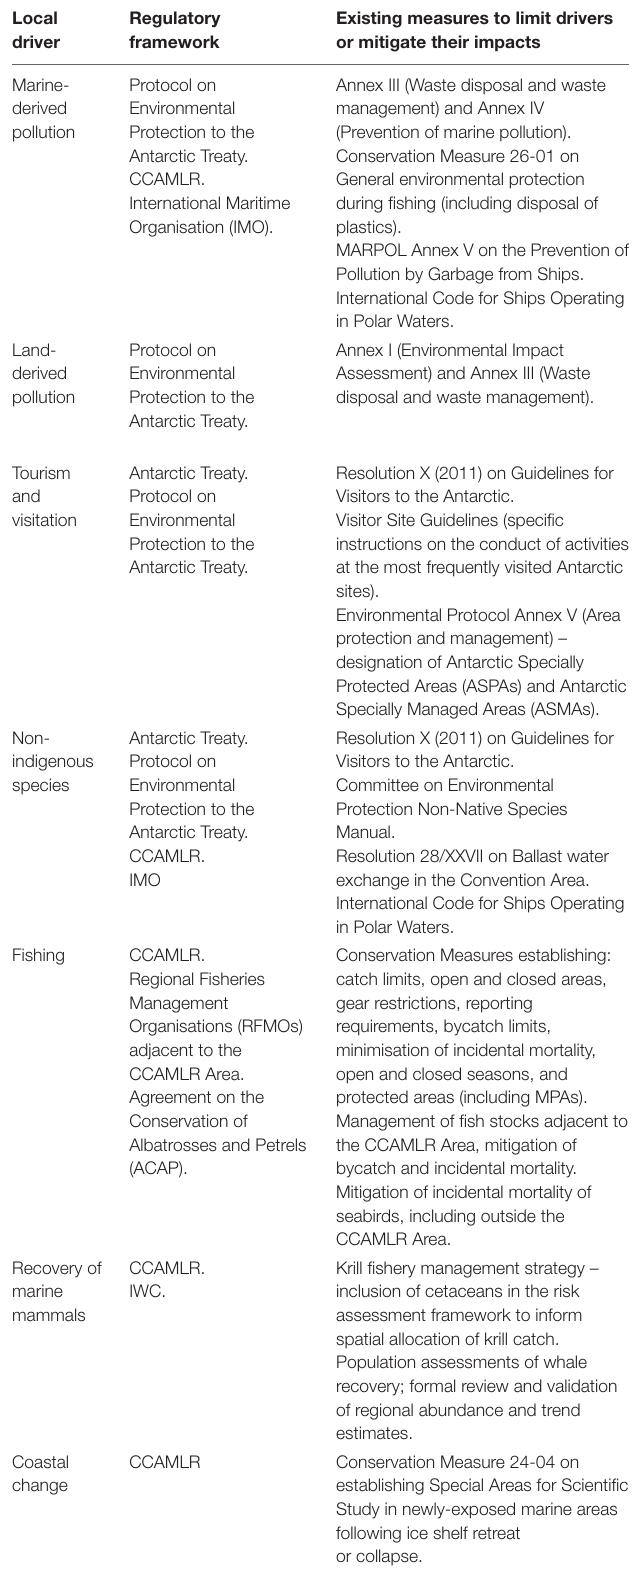
TABLE 2 | Regulatory frameworks establishing measures relevant to specific local